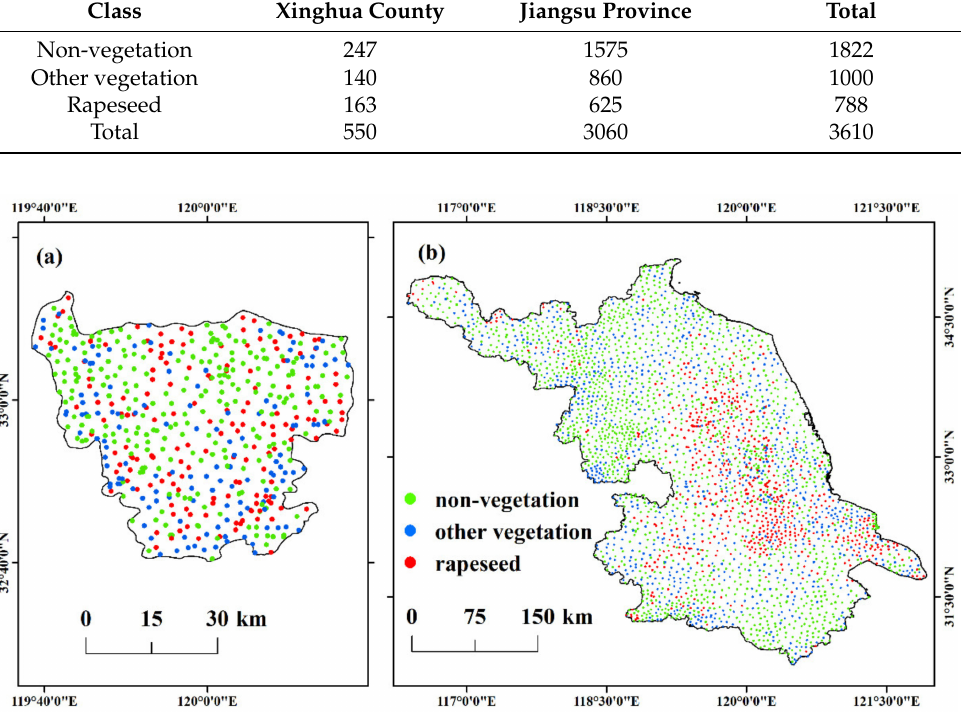
Figure 2. Location of samples: ( a ) the distribution of training and validation samples in Xinghua County; ( b ) the distribution of validation samples in Jiangsu